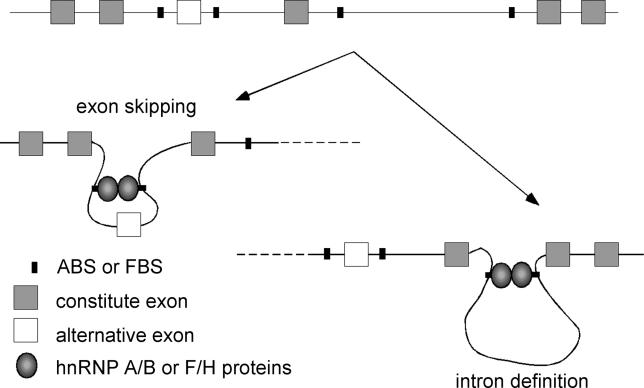
The Looping-Out Model of Action for hnRNP A/B and hnRNP F/H ProteinshnRNP proteins bound to high-affinity binding sites (ABS or FBS) would self-interact to loop out intron sequences and stimulate intron definition.A similar interaction involving ABS or FBS located in distinct introns would loop out an alternative splice site or a cassette exon to favor skipping and commitment between the external pair of splice sites. It remains unknown as to whether heterotypic interactions can occur between hnRNP A/B and hnRNP F/H proteins.